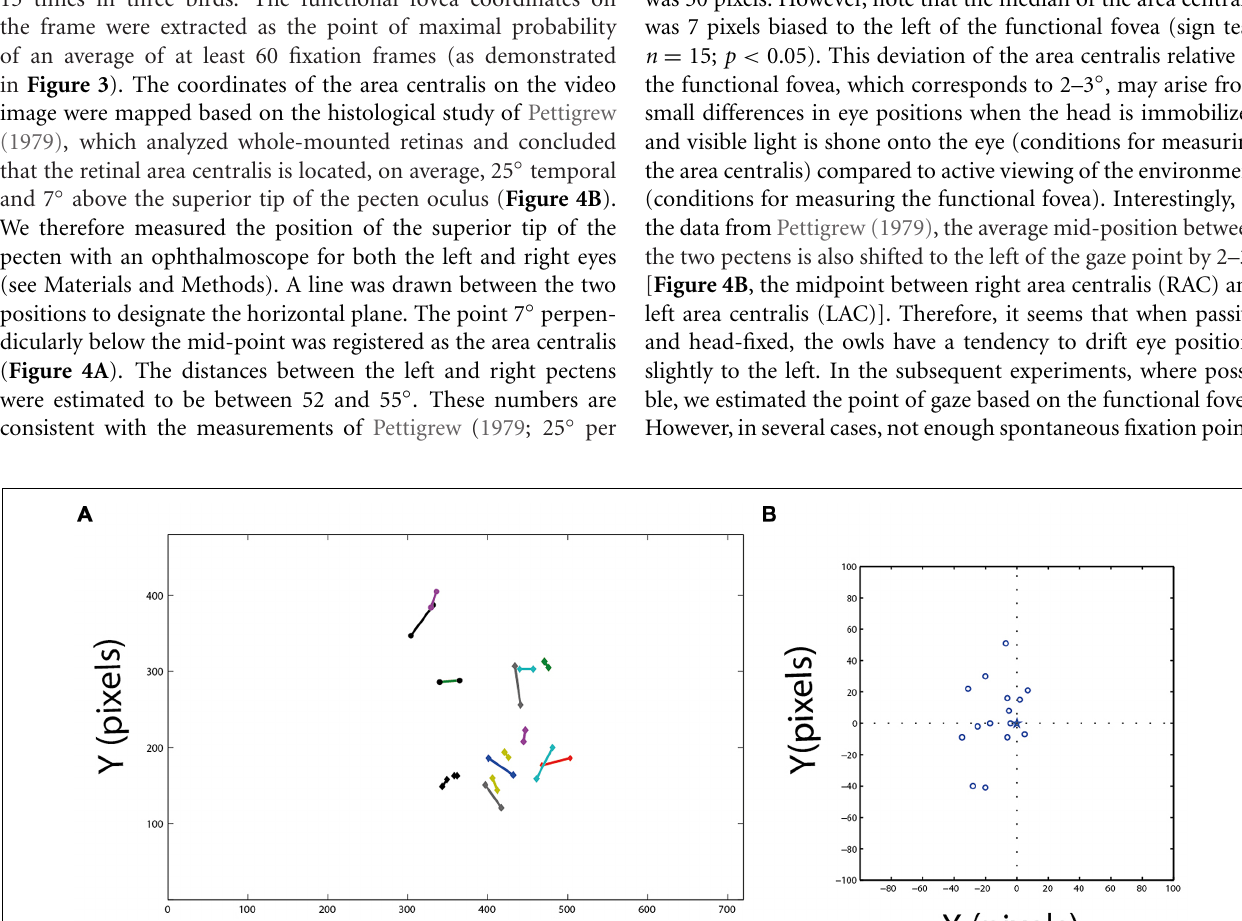
projections of area centralis from panel (A) are shown in relation to the position of the corresponding functional fovea. Dash lines mark the zero axes and star marks the position of the functional fovea at the